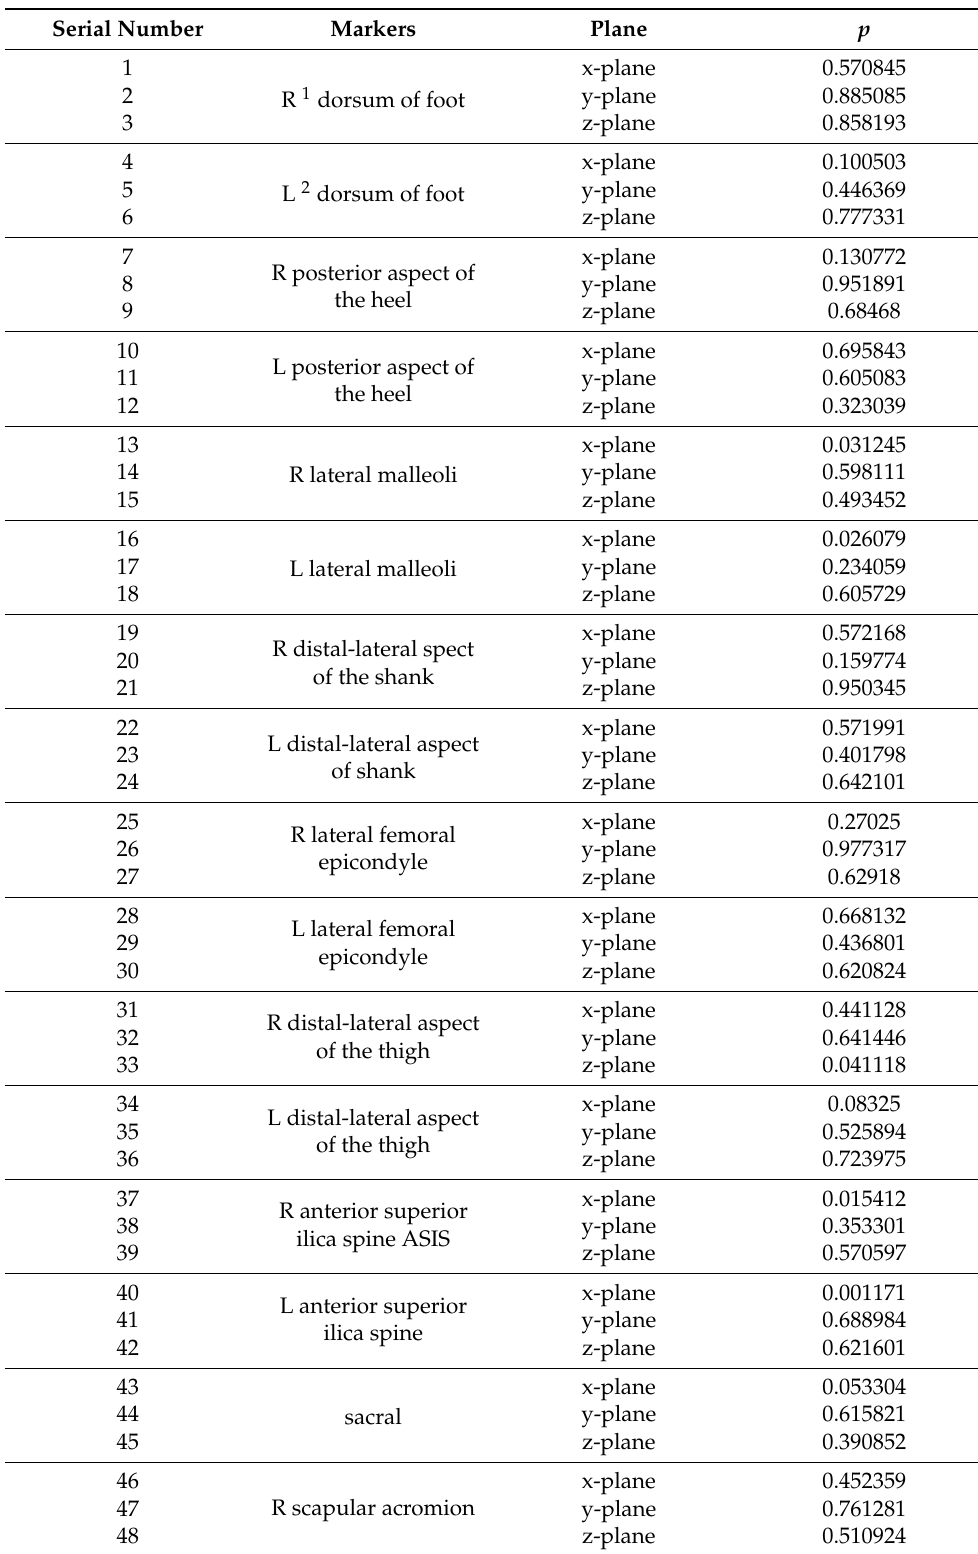
Table 3. The significant differences between different